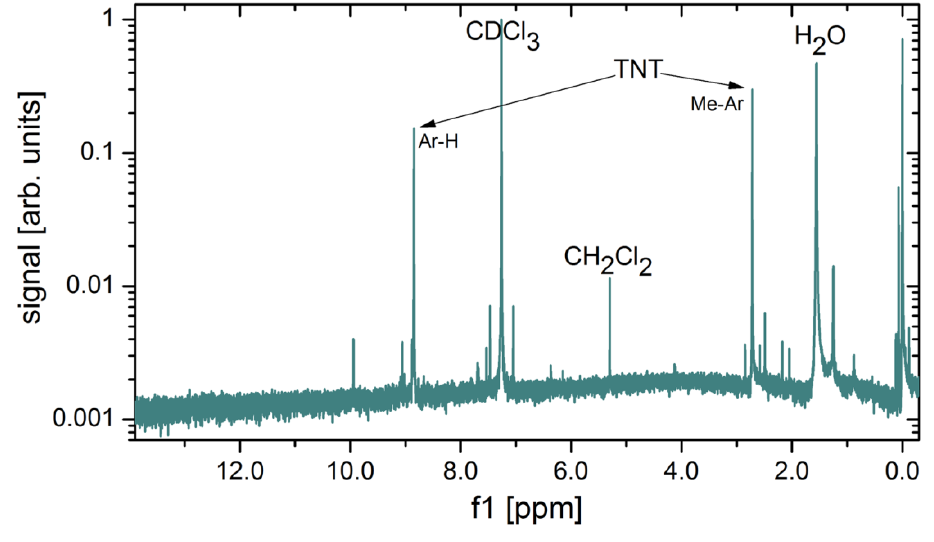
Figure 19 . NMR spectra of the material collected from 1000 L of gas mixture using a cold trap. The flow through a glass tube immersed in liquid nitrogen was set to 100 mL/min (as during normal operation of vapor generator). A peak of solvent deuterated chloroform (CDCl ), a water peak (H O), a CH Cl peak, and TNT peaks (Me–Ar and Ar–H) can 3 2 2 2 clearly be seen, all other impurities are present only in traces. CH Cl is a solvent, which 2 2 was used for deposition of TNT onto glass